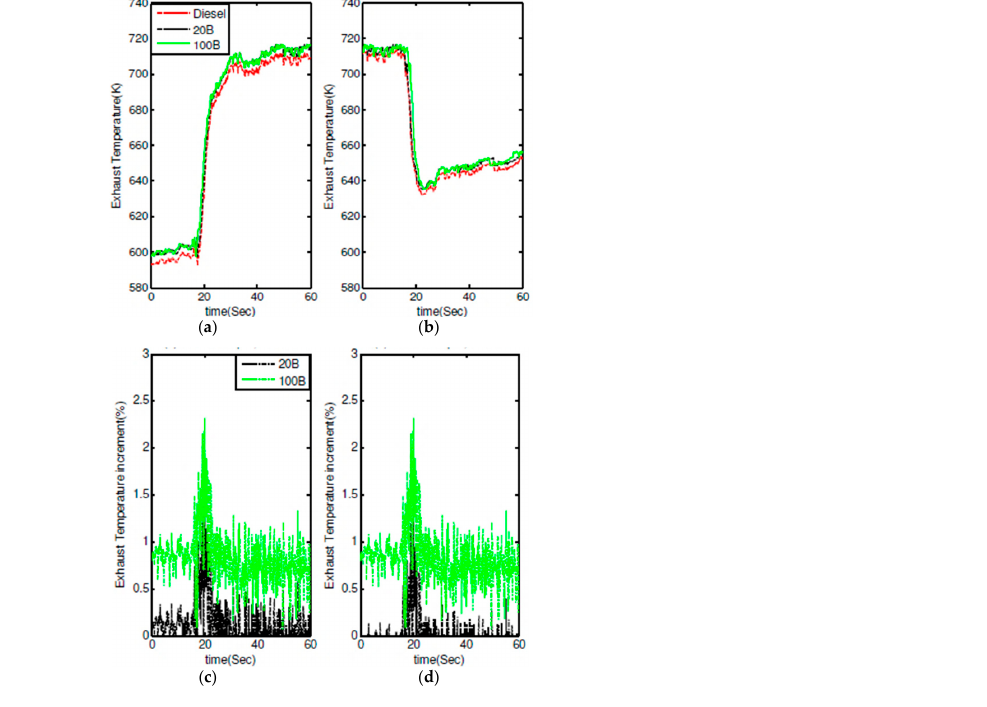
Figure 5. Exhaust temperature of the CI engine fuelled with diesel and biodiesel blends at a speed stable at 420 Nm. ( a , b ) Exhaust temperatures at positive and negative torque transients and ( c , d ) exhaust temperature % increase.